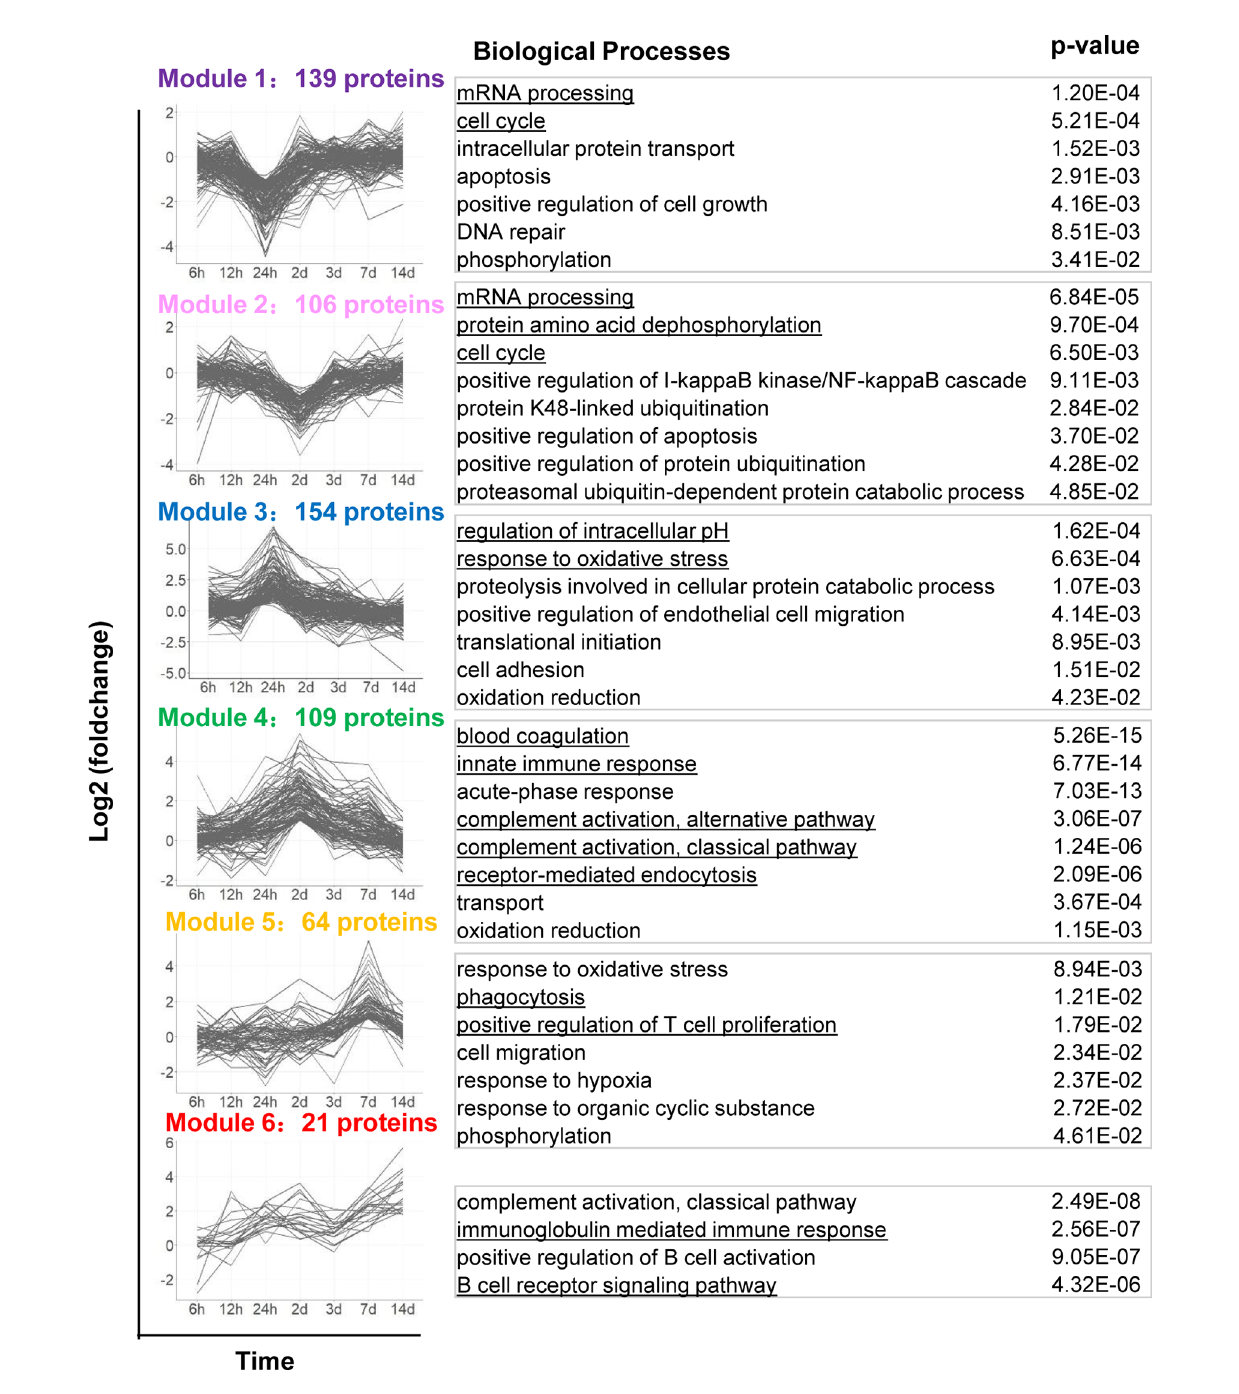
FIGURE 3 | Dynamic protein co-expression modules classi fi ed by k -means analysis with GO annotation. The left panel shows the six modules classi fi ed by the k -means clustering analysis, according to their dynamic co-expression patterns. x-axis represents sampling time, y-axis represents log2 fold-change of protein intensity. The right panel shows the corresponding GO Biological Process terms to each